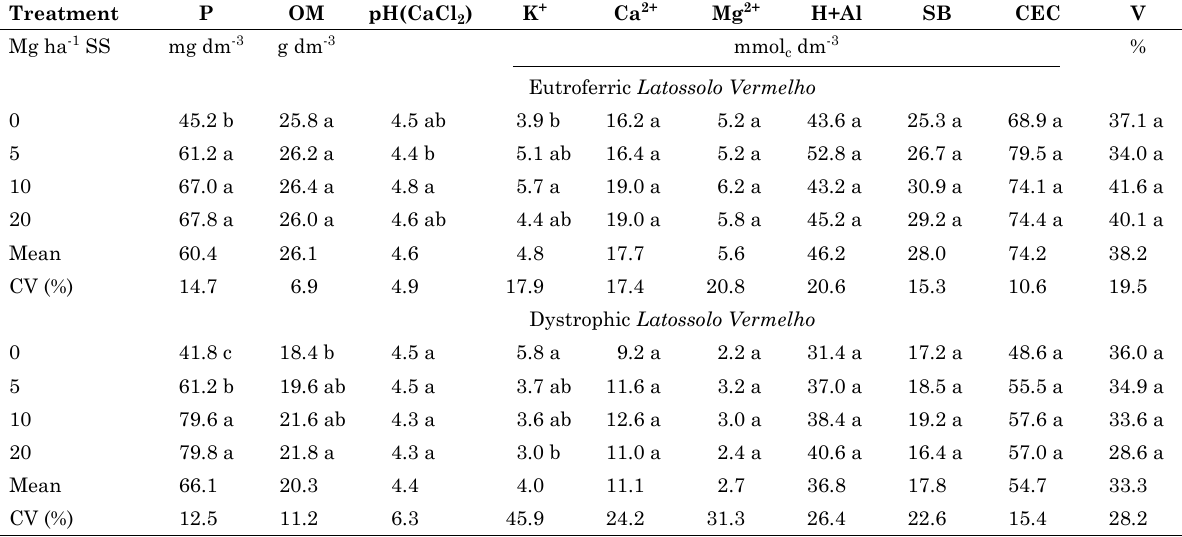
table 5. Chemical properties of eutroferric and dystrophic Latossolos Vermelhos in the 0.00-0.20 m layer, treated for 16 years with sewage sludge at different rates treatment P om ph(CaCl 2 ) K + Ca 2+ mg 2+ sB CeC V Mg ha -1 SS mg dm -3 g dm -3 mmol c dm -3 Eutroferric Latossolo